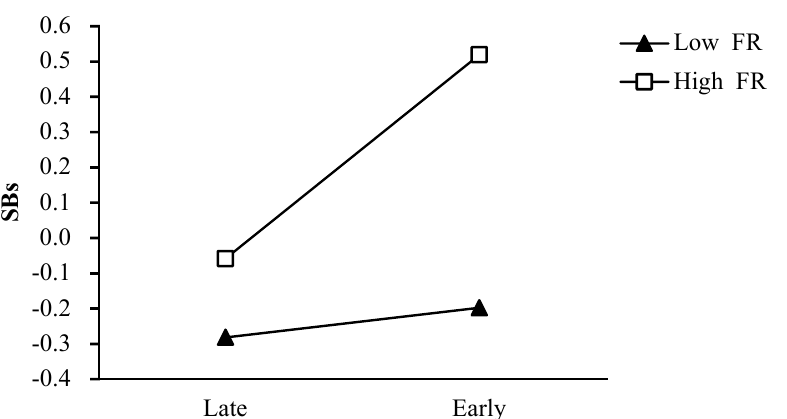
Figure 1. The two − way interaction between PT and FR in predicting boys’ SBs. Note: PT pubertal Figure 1. The two−way interaction between PT and FR in predicting boys’ SBs. Note: PT pubertal timing, FR father rejection, SBs smoking timing, FR father rejection, SBs smoking behaviors.